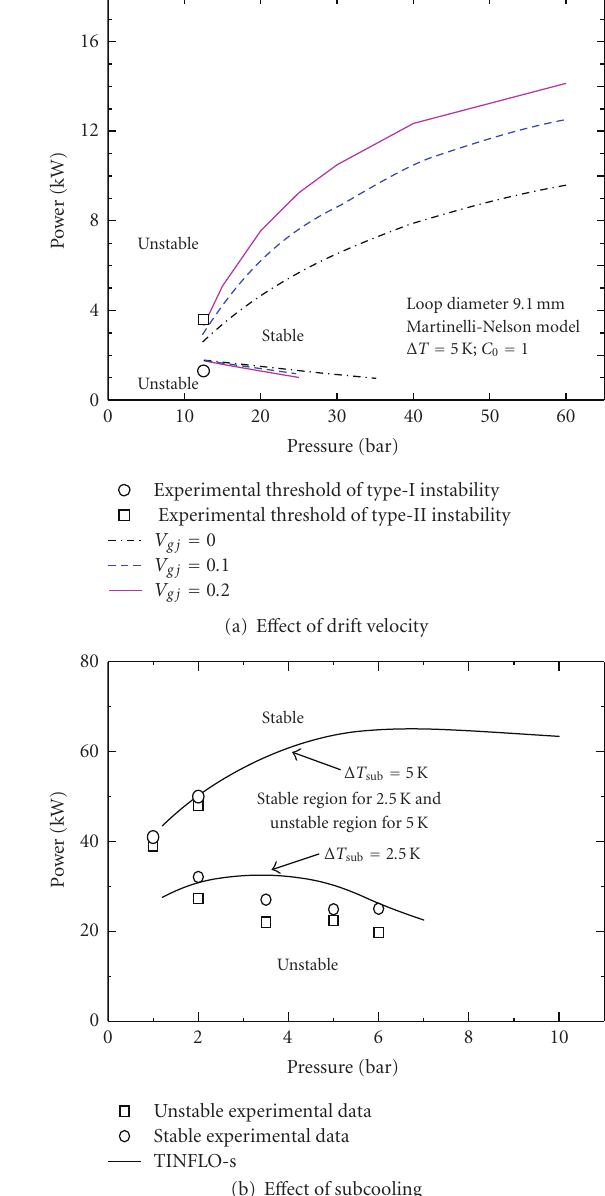
Figure 20: Comparison of measured and predicted stability maps. shows that this situation arises in large diameter loops.